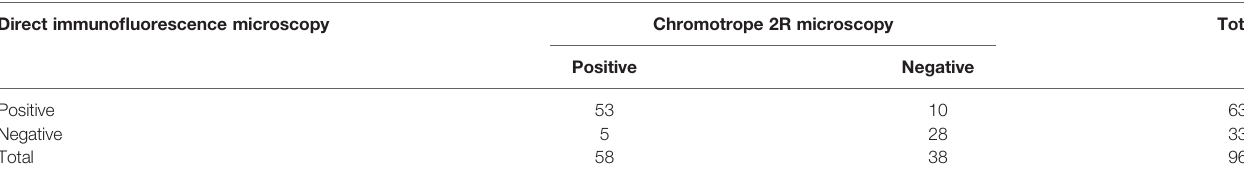
TABLE 1 | Performance of direct immuno fl uorescence assay for the detection of Enterocytozoon bieneusi in comparison with chromotrope 2R-based microscopy*. Direct immuno fl uorescence